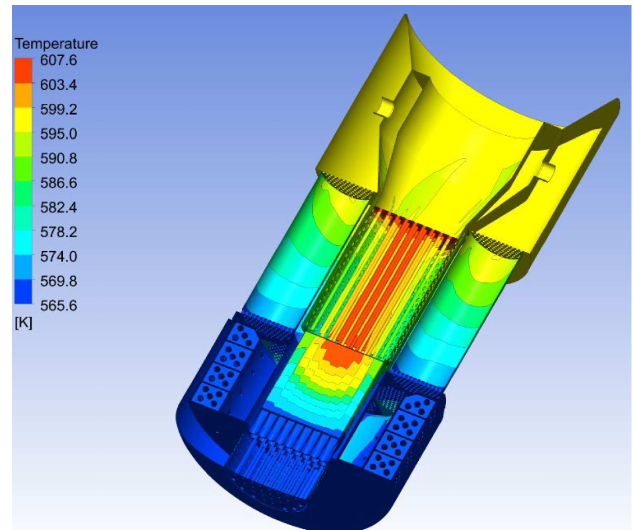
Fig. 11. CFD model of the integral SMART plant developed by KIT